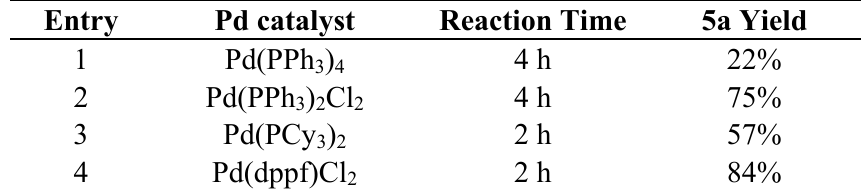
Table 1. Screening of palladium catalysts for the Suzuki coupling of 5-bromo-1-ethyl-1 H - indazole and N -Boc-2-pyrroleboronic